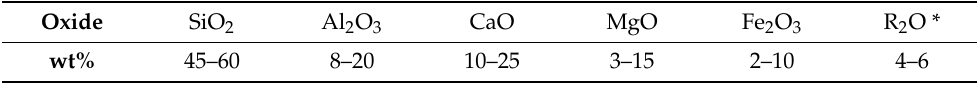
Table 2. Oxides content ranges (in wt%).